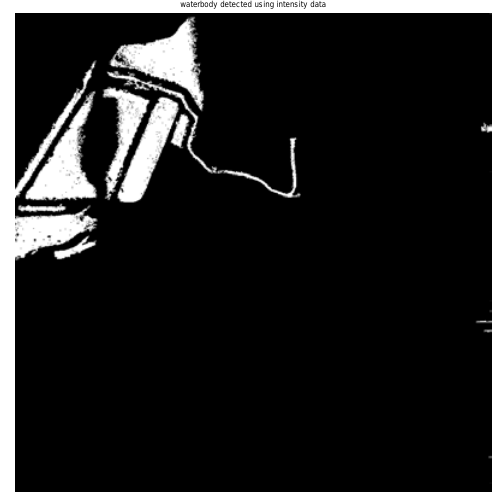
Figure 8. Water bodies detected using intensity data 2.6 Merging detections from elevation and intensity data After detecting water bodies from elevation and intensity data, we merged the detections using a logical OR operation. We rejected areas less than half acre in size using connected component analysis and for the rest of the areas, we did the continuity test as described in section 2.5. Then using morphological operations, we closed small gaps or voids in the detected water bodies. The final detected water bodies are shown in figure 9.